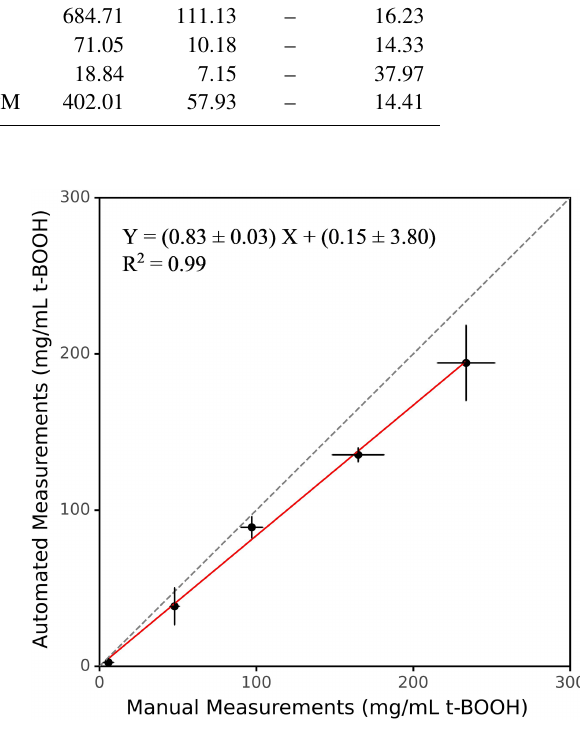
Figure 4. Comparison between manual and automated measure- ments of OP for a positive control (t-BOOH). Dotted line represents the identity